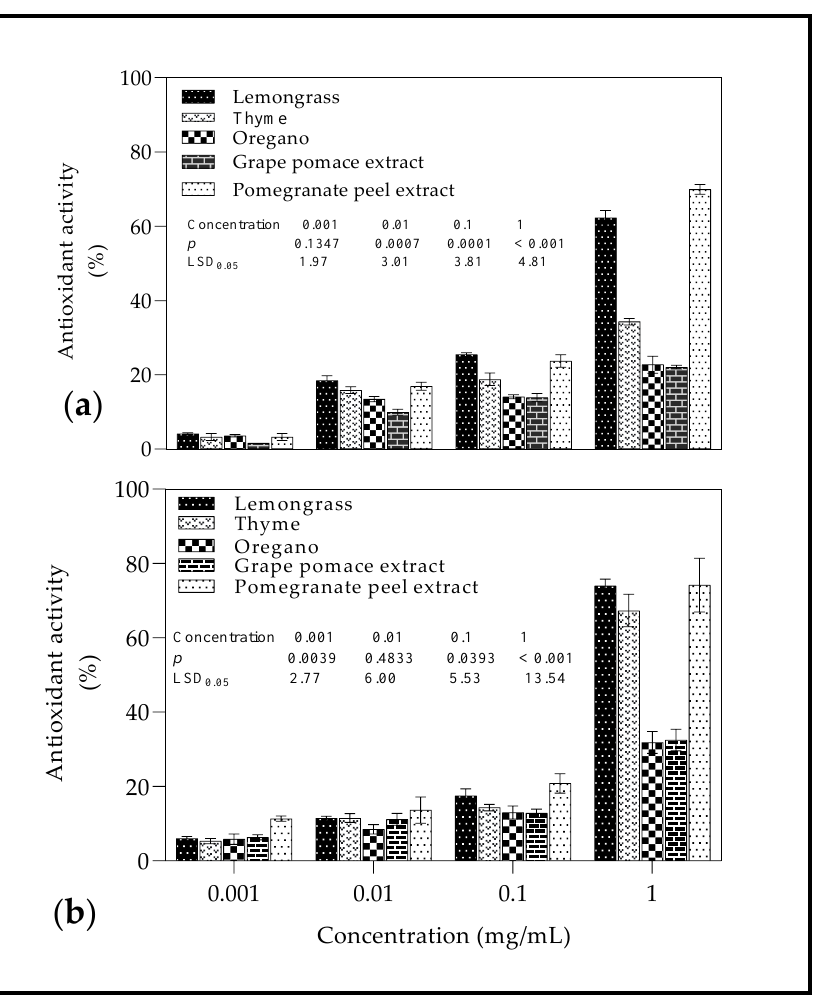
Figure 3. Antioxidant capacity of essential oils and plant extracts at different concentrations (0.1–1 mg/mL) evaluated by ( a ) DPPH and ( b ) ABTS assays. Vertical bars represent the standard error (SE) of mean values of three replicates. LSD 0.05 represent least significant difference ( p < 0.05).